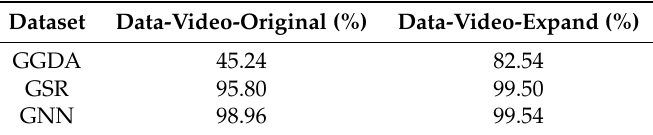
Table 3. The accuracy of these two